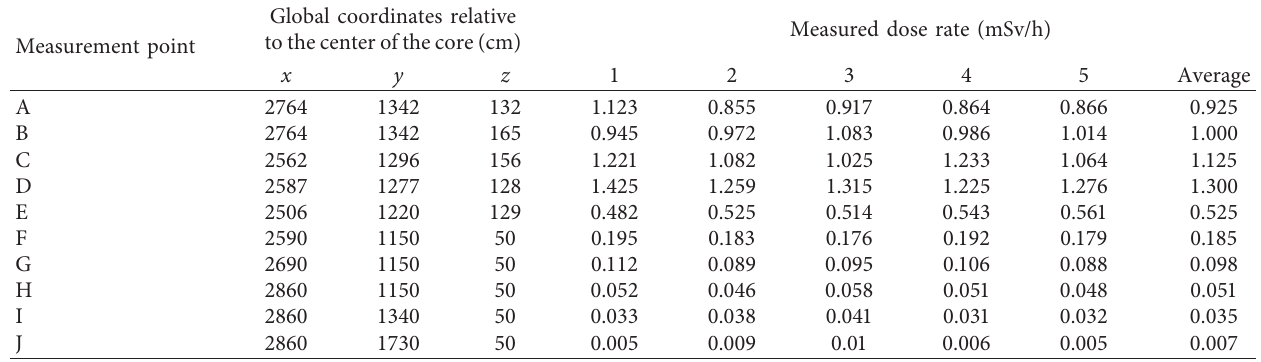
Table 1: Information of dose rate in the selected typical radiological compartment.